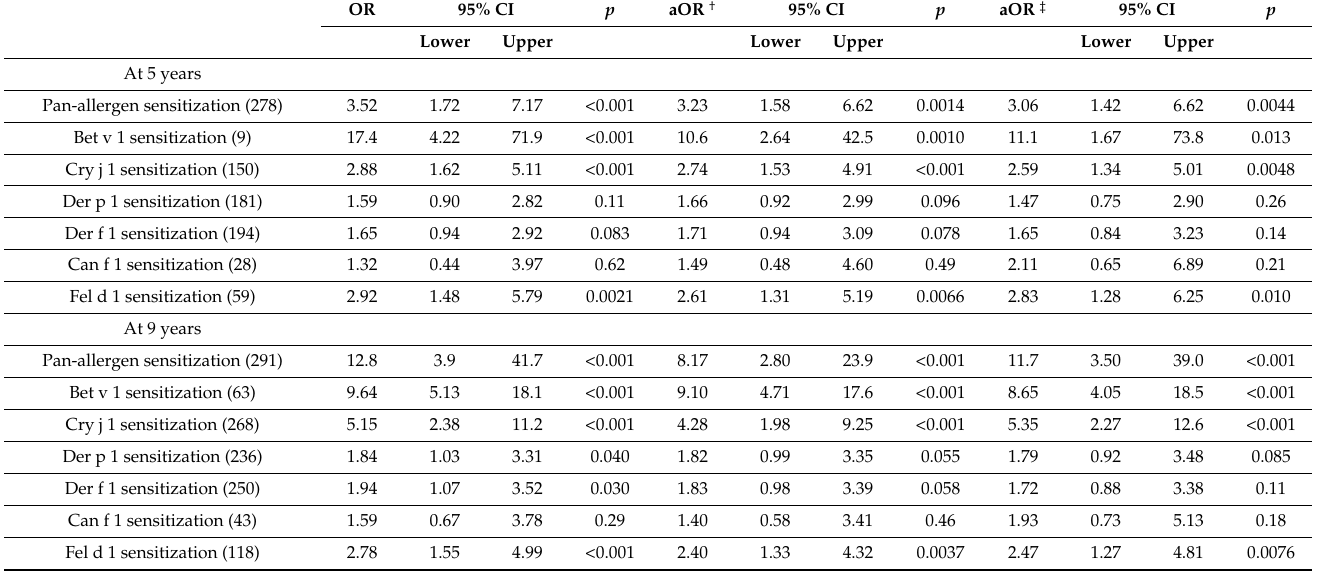
Table 1. Association between allergen sensitization at 5 or 9 years and PFAS at 13 years of